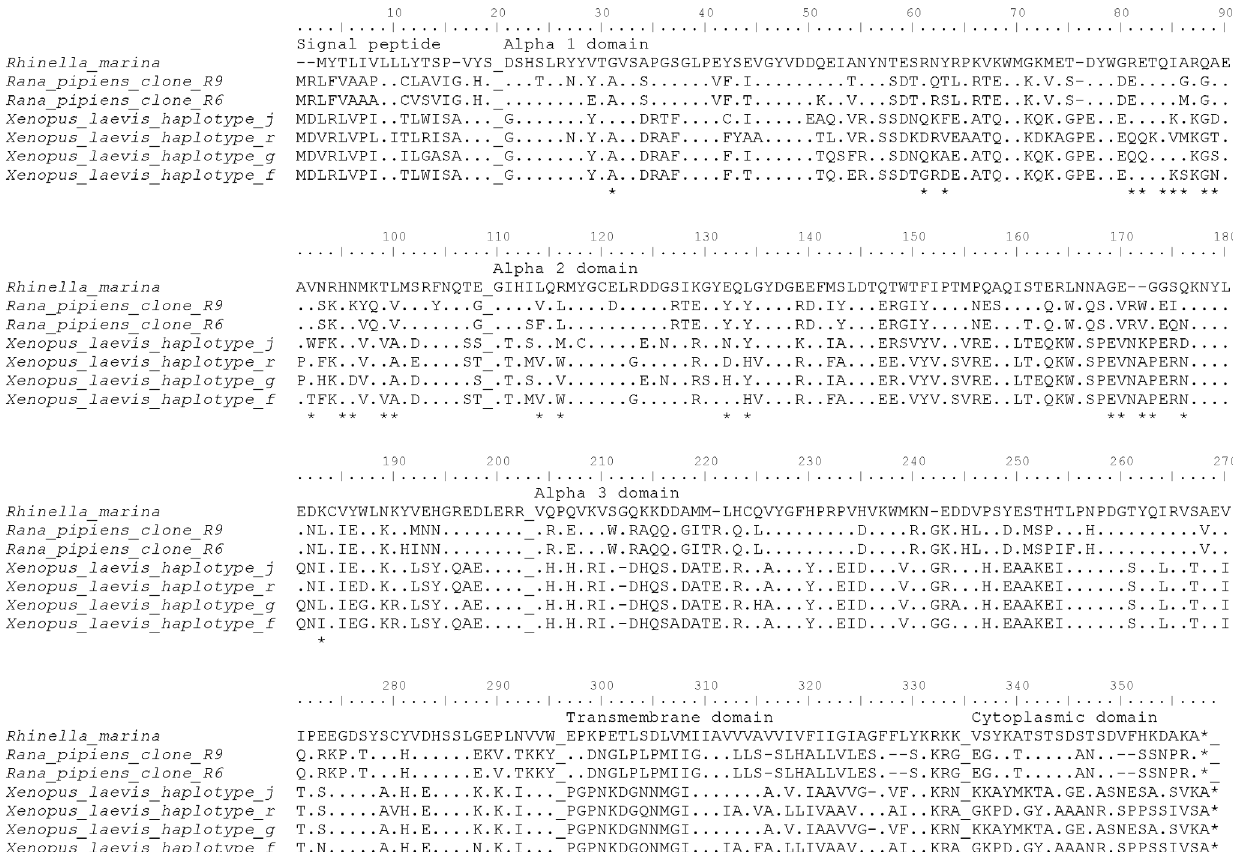
Figure 1. Amino acid alignment of anuran MHC class I. ClustalW alignment of MHC class I from Rhinella marina, Rana pipiens (MHC class I clone R6 Genbank accession no.: AF185587 and R9: AF185588) and Xenopus laevis (MHC class I haplotype g: AF188579; haplotype f: AF188580; haplotype r: AF188582 and haplotype j: AF188586); * indicate putative peptide binding residues as predicted from Flajnik et al. 1999.